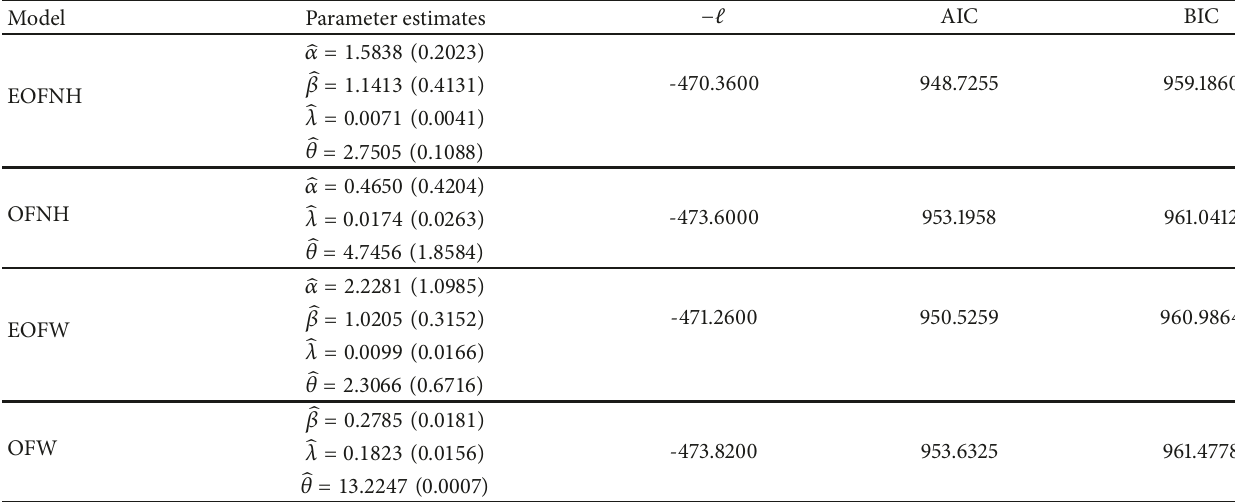
Table 3: Maximum likelihood estimates and goodness-of-fit